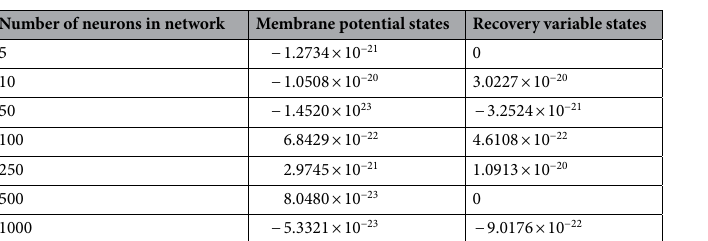
Number of neurons in